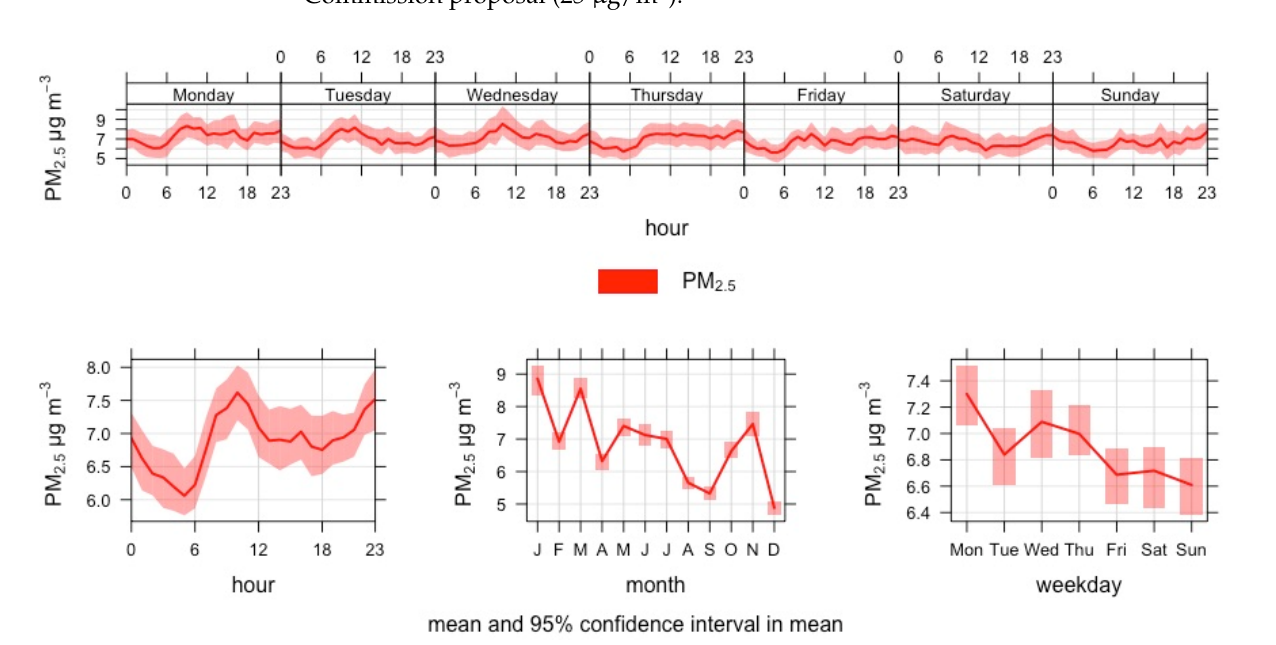
Table 5. Multivariable linear regression analysis results for vessel arrivals, departures, movement and laying alongside to the logarithm of PM 2 . 5 hourly mean concentrations controlled for wind di- rection, wind speed, relative humidity and time of day at Vuosaari 2016. p -values less than 0.05 in bold. Coefficient 95% Conf. Interval